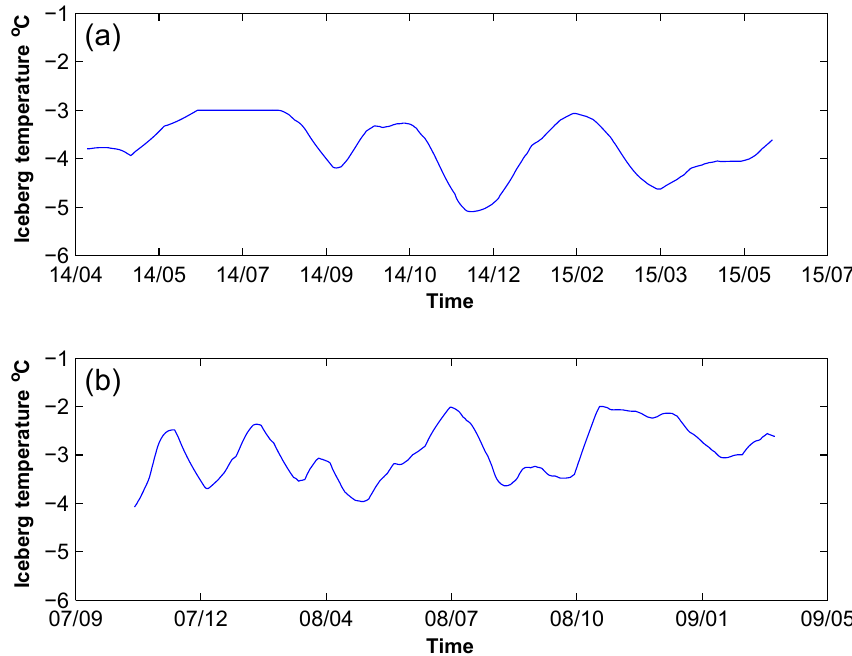
Figure 10. Fitted iceberg temperature for B17a (a) and C19a (b)